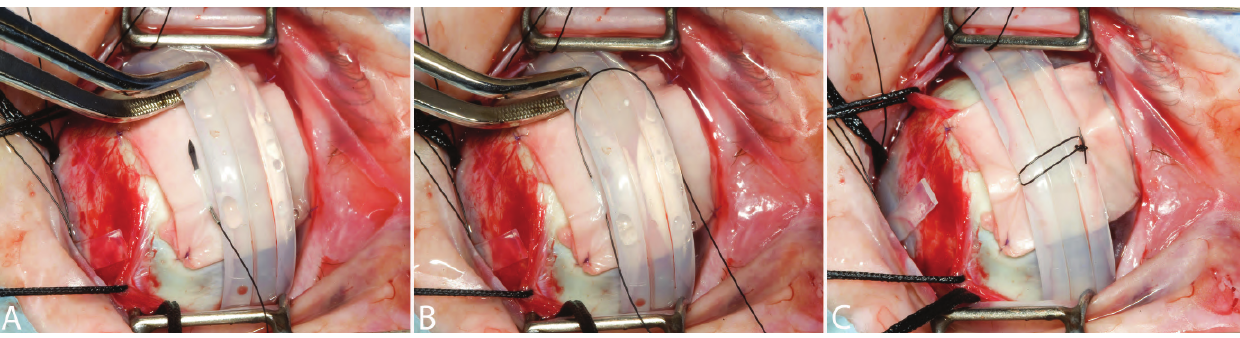
Figure 2. Intraoperative external photograph of the same patient in Figure 1 showing Tutoplast covering the extensive scleral thinning superotemporally with 7-0 Vicryl sutures tacking the Tutoplast to thicker sclera at each corner (A). A horizontal mattress suture using 5-0 nylon is then placed within the Tutoplast and not in the sclera itself (B). The suture is then tied around the scleral buckle (A–C) and the knot is rotated inferiorly